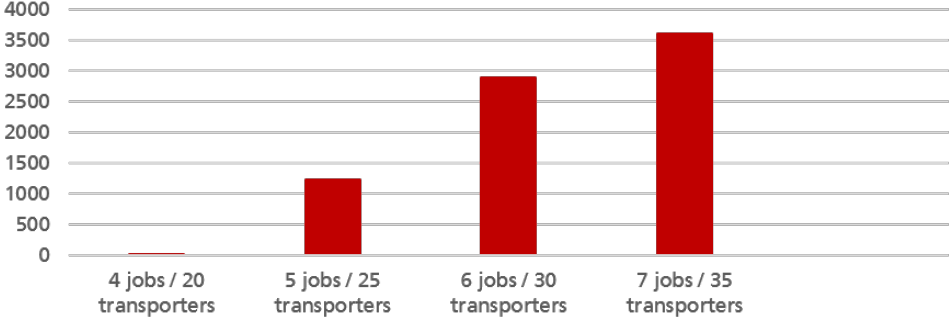
Figure 4. Average running time of Algorithm ( S MIP ) over five randomly generated instances, in seconds. We set up the solver with a one hour time-out limit, such that an instance takes a maximum of 3600 s